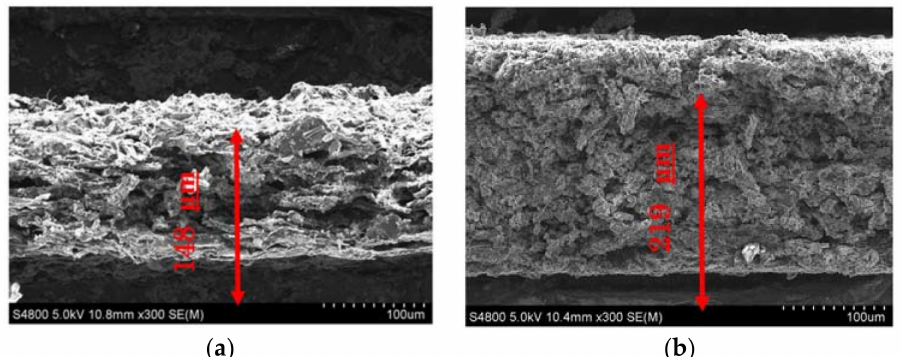
Figure 7. SEM images of the Si/G/CP composite electrode with 24 wt % and 1.0 µ m Si. ( a ) Initial and ( b ) after 100 cycles.